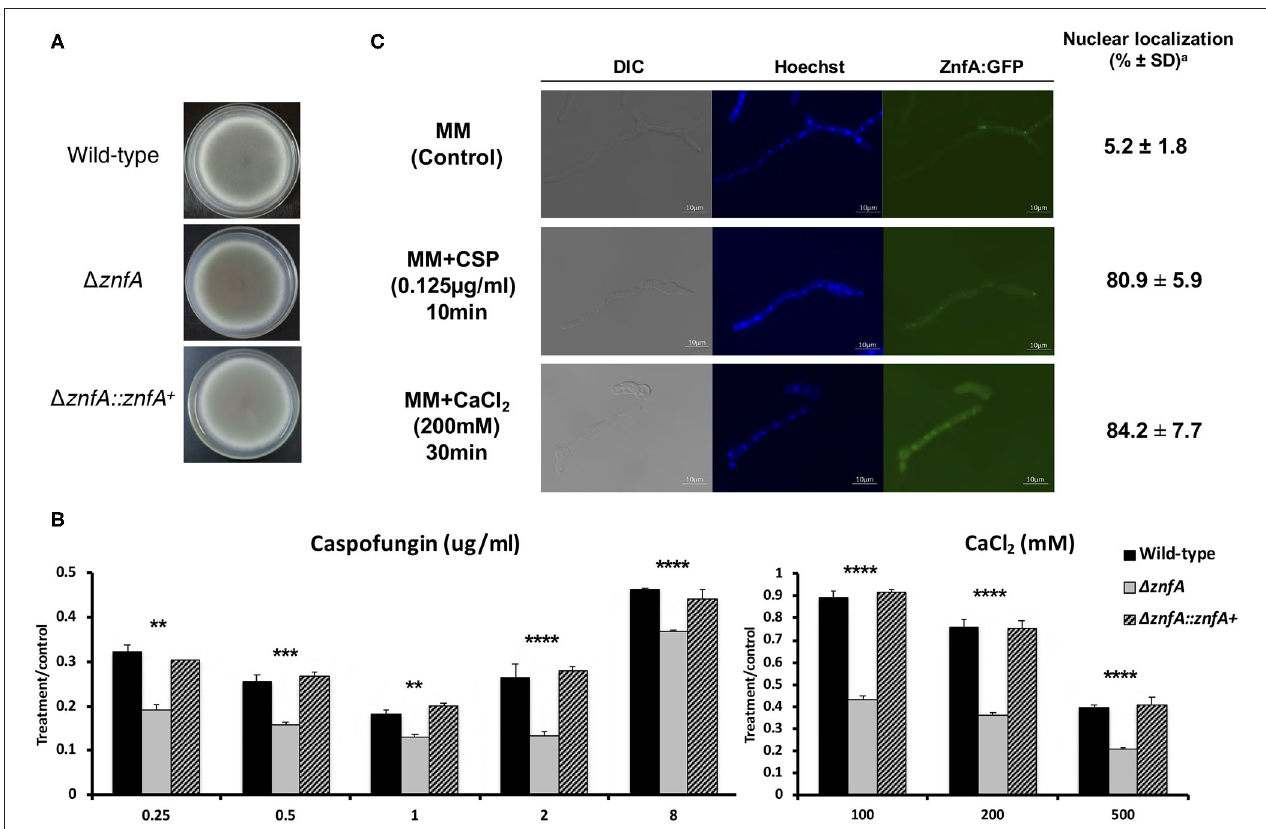
FIGURE 1 | A. fumigatus ZnfA transcription factor is involved in calcium and caspofungin tolerance mechanisms. Growth phenotypes of the wild-type, 1 znfA , and 1 znfA :: znfA + strains grown for 5 days at 37 ◦ C in solid (A) MM and in the presence of increasing concentrations of (B) CaCl represent averages of results from three independent biological repetitions. Statistical analysis was performed using one-tailed, paired t -tests for comparisons to the control condition (** P < 0.01; *** P < 0.001; **** P < 0.0001). (C) ZnfA:GFP germlings were grown for 16h at 37 ◦ C in MM and exposed to 0.125 µ g/ml of Caspofungin for 10min and 200mM CaCl 2 for 15min for 30min. Bar, 10mm. a The percentage of ZnfA:GFP nuclear localization is based on counting 300–500 nuclei in 50–100 hyphal germlings of biological